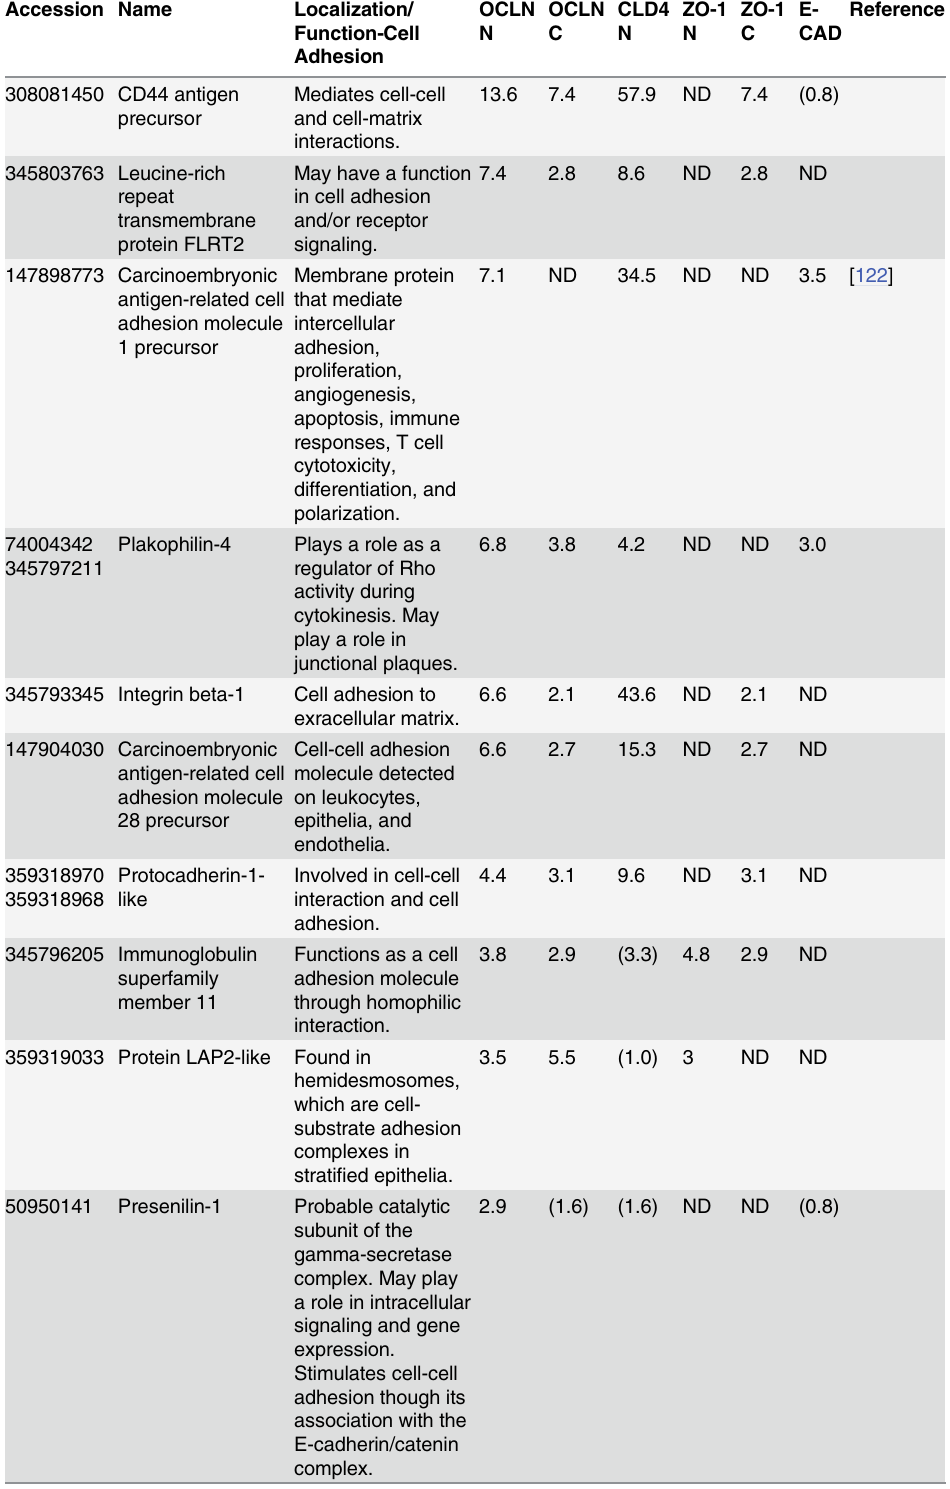
Table 6. Enriched cell adhesion proteins tagged by biotin ligase fused to occludin and